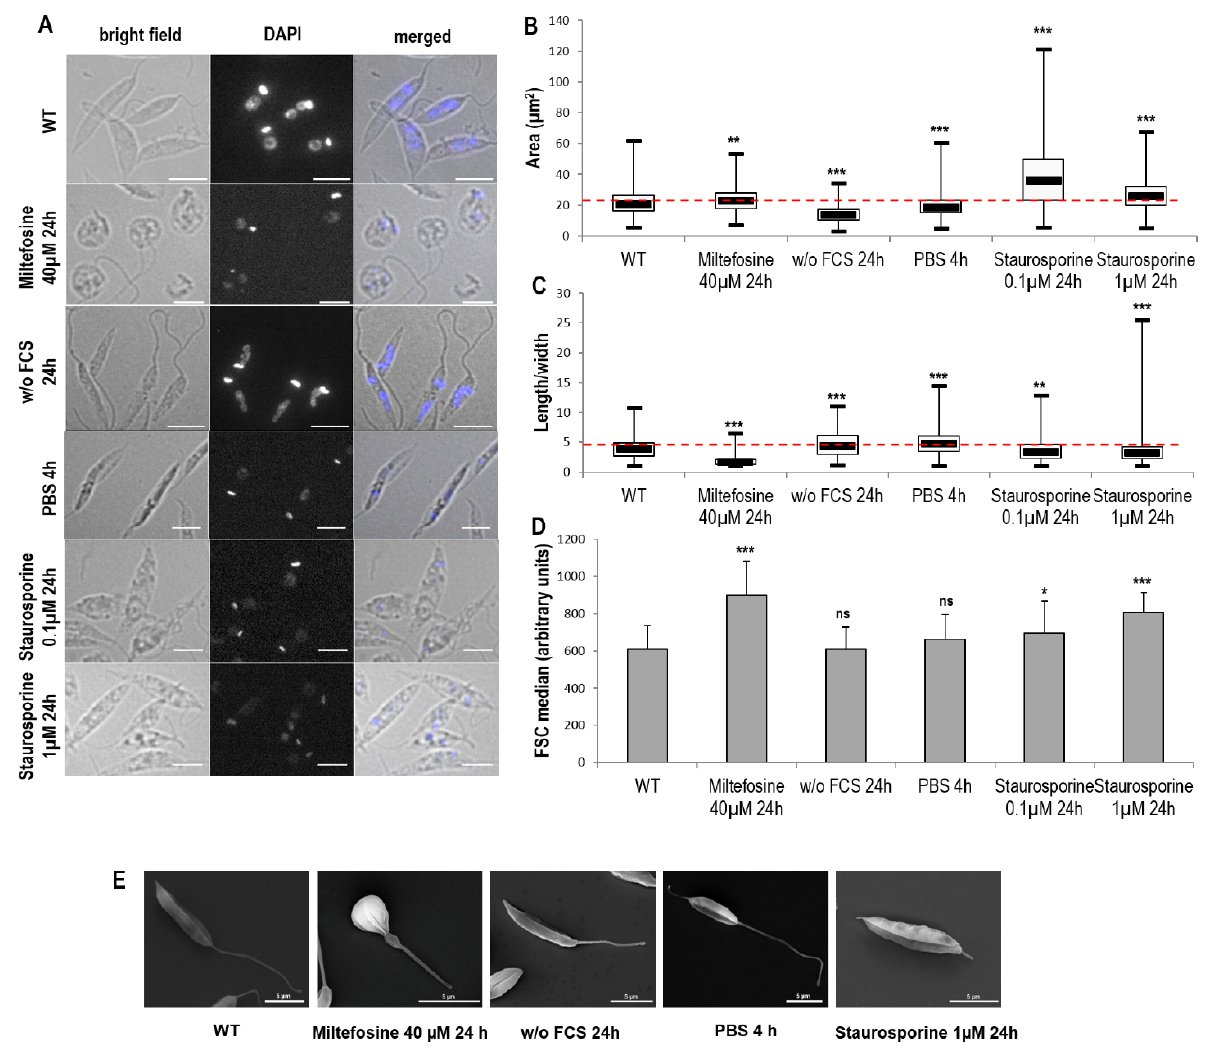
FIGURE 2: Cell morphology during Leishmania cell death and autophagy. (A) Microscopical observation of cells in different culture condi- tions: bright field, DAPI and bright field/DAPI merged image (bar = 5µm). (B-C) Box plots representing area (B) and length-to-width ratio (C) of cells cultivated in different conditions. A minimum of 475 cells were counted for each condition, from a minimum of three independent experiments. The thick line inside each box represents the median value; the lower and upper edge of each box indicates the 25 th and 75 th percentiles, respectively; the lower and upper whiskers (ends of the box arms) represent the minimum and maximum, respectively. (D) FSC median calculated by flow cytometry of cells cultivated in different conditions. Mean ± SD from a minimum of thirteen independent experi- ments. (E) Scanning electron microscopy representative images (bar = 5 µm). Unpaired t-test: ns not significant, * p < 0.05, ** p < 0.01, *** p <